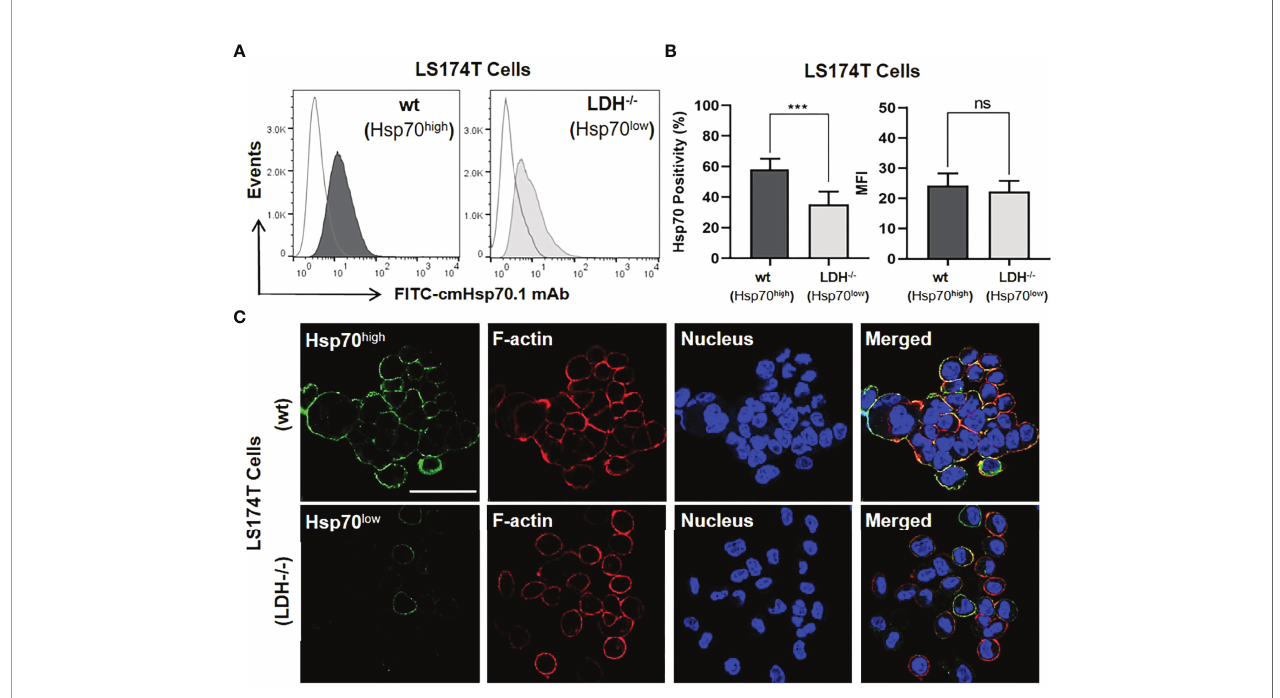
FIGURE 1 | Membrane Hsp70 (mHsp70) expression on isogenic lines of LS174T cells expressing high and low densities of mHsp70 (Hsp70 high , Hsp70 low ). (A) Representative fl ow cytometric histogram of mHsp70 expression using FITC-cmHsp70.1 monoclonal antibody (mAb). Dark (wild type, wt) and light (Lactate dehydrogenase A/B knock-out, LDH -/- ) gray histograms. Isotype-matched (Mouse FITC-IgG1) mAb was used as negative control (white histograms). (B) Percentage of viable Hsp70 high and Hsp70 low LS174T wt and LDH -/- cells expressing mHsp70 and MFI (mean ± SD, n ≥ 3 independent experiments; ns, not signi fi cant; ***p ≤ 0.001). (C) Representative confocal microscopy images of Hsp70 high and Hsp70 low LS174T cells using FITC-cmHsp70.1 mAb (green). Nuclei were stained with DAPI (blue) and actin skeleton with rhodamine-phalloidin (red). The scale bar is 50